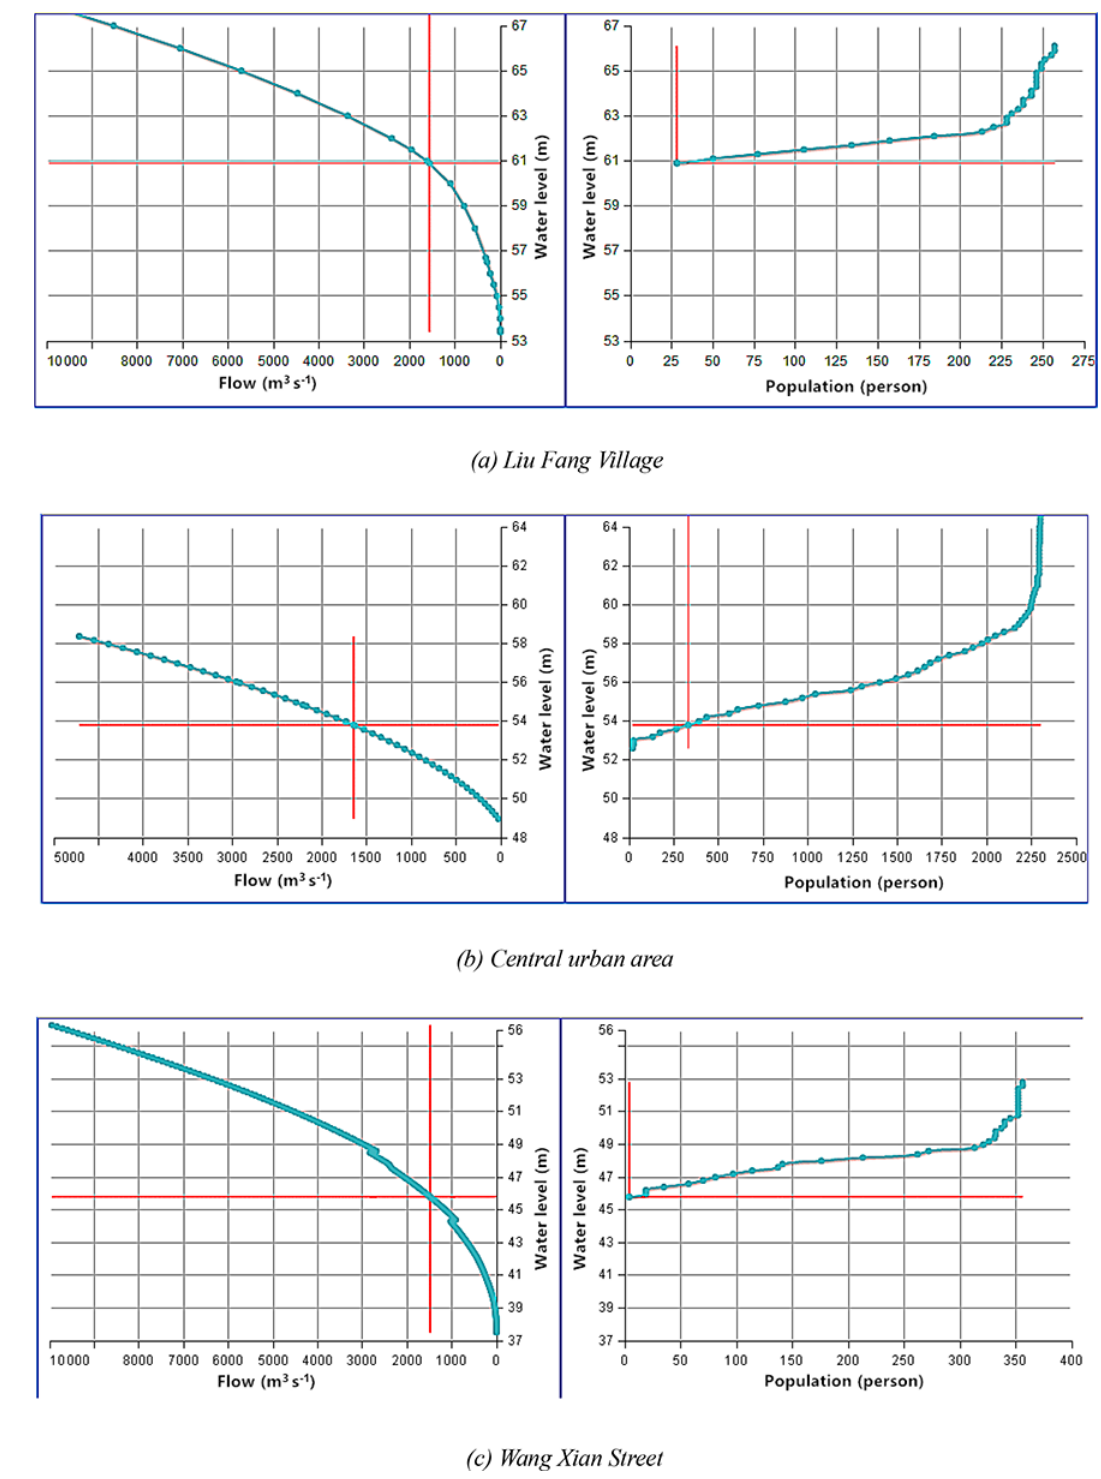
Figure 8. Results of the investigation points of upstream and downstream associated river sections in Shitai area on the same axis and two